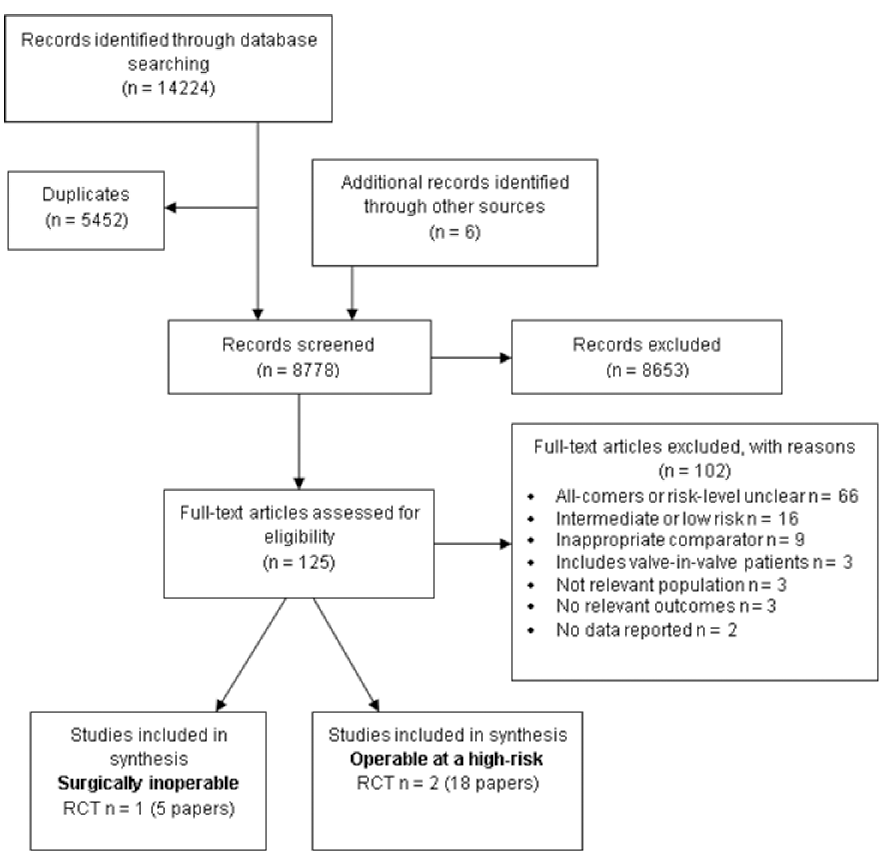
Fig 1. Flow diagram presenting the search and selection